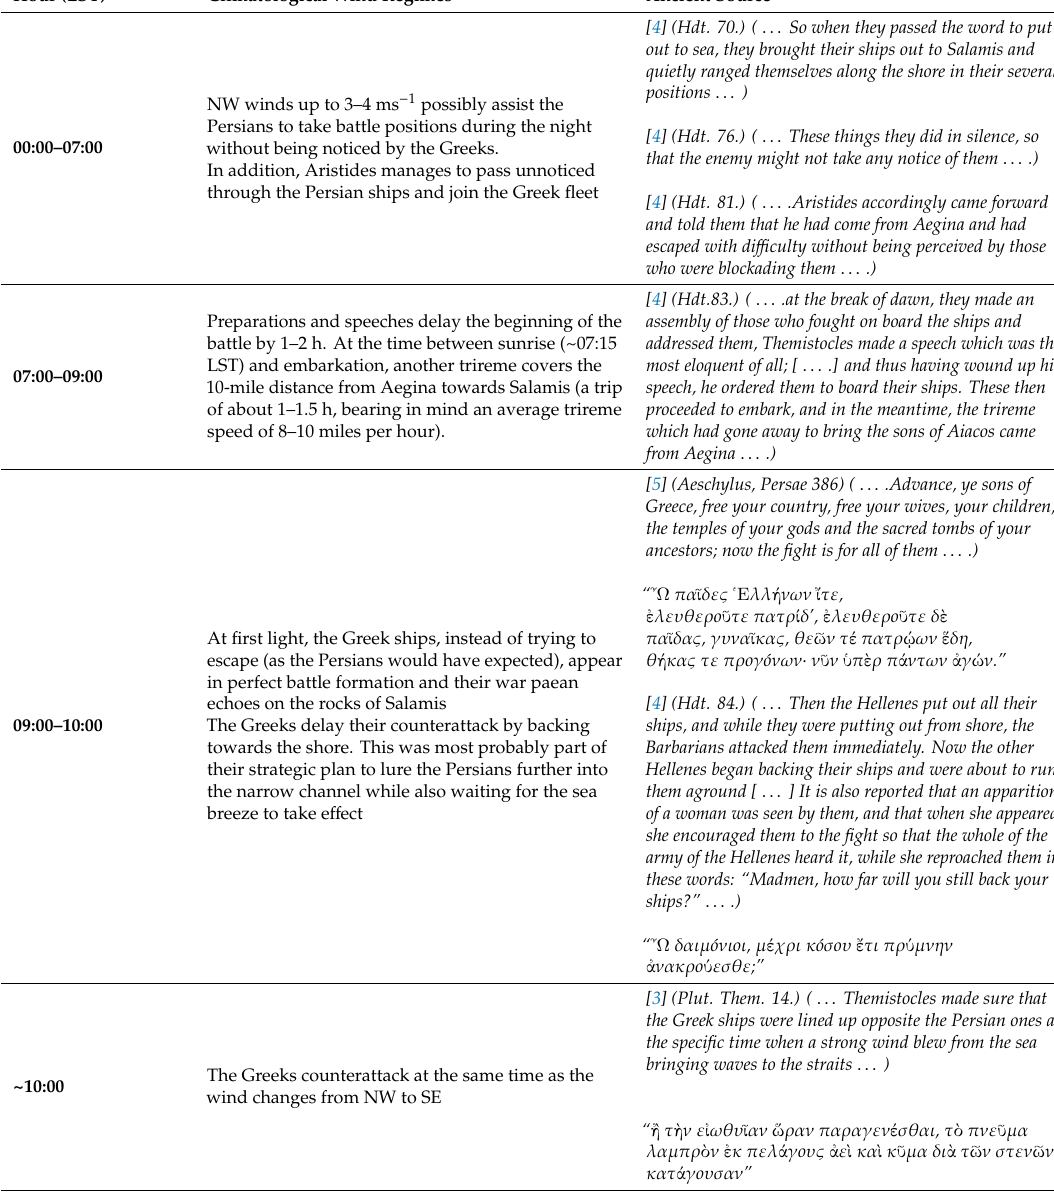
Table 1. Weather conditions and related course of events on the day of Salamis